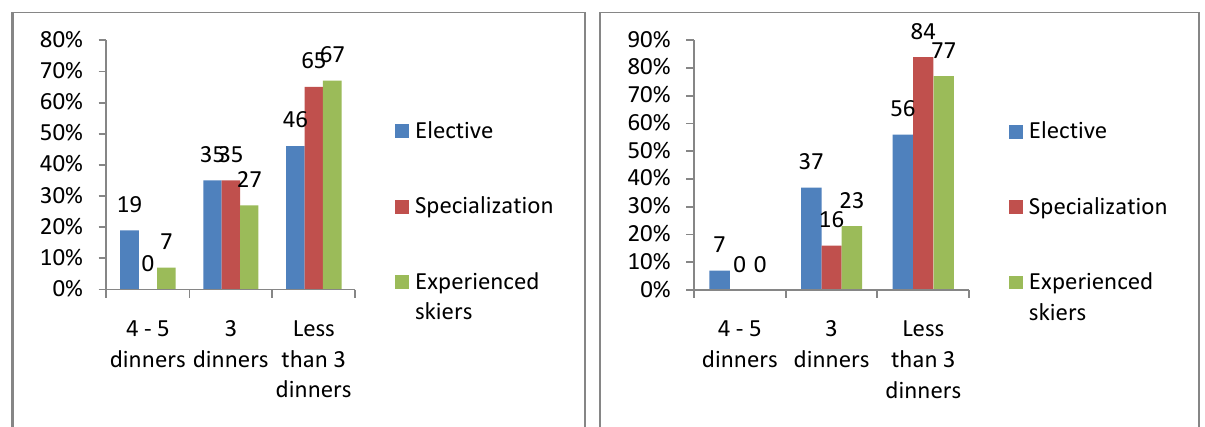
Figure 3. Daily intake of dairy products Figure 4. Daily intake of animal protein